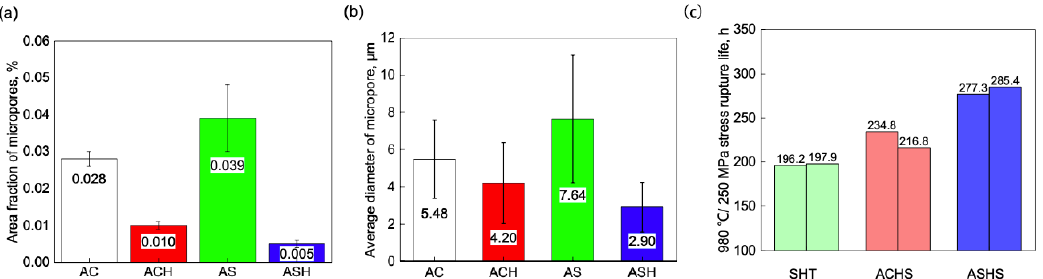
Figure 17. The diagrams of average area fractions and diameters of micropores. AC: as-cast state; ACH: as-cast + HIP state; AS: as-solid-solution state; ASH: as-solid-solution + HIP state. ( a ) Average area fraction of micropores; ( b ) Average diameter of micropores. ( c ) The high temperature stress